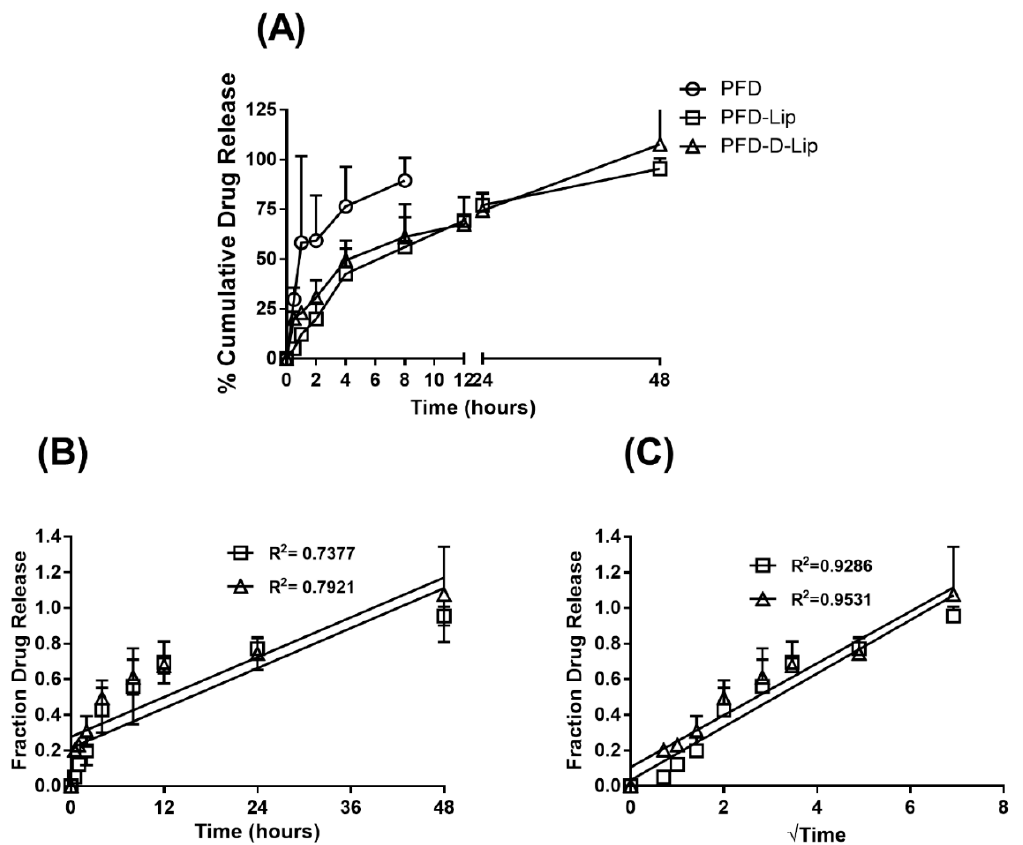
Figure 2. Comparative plots of ( A ) % Cumulative in vitro drug release profile of PFD, PFD–Lip, and PFD–D-Lip, ( B ) zero order release kinetics and ( C ) Higuchi release kinetics from PFD–Lip and PFD–D-Lip in simulated lung fluid (SLF-3 with DPPC liposomes; pH 7.4) at 37 ° C. Data represent mean ± SD ( n = 3). Drug release data was found to best fitted to the Higuchi kinetic model.